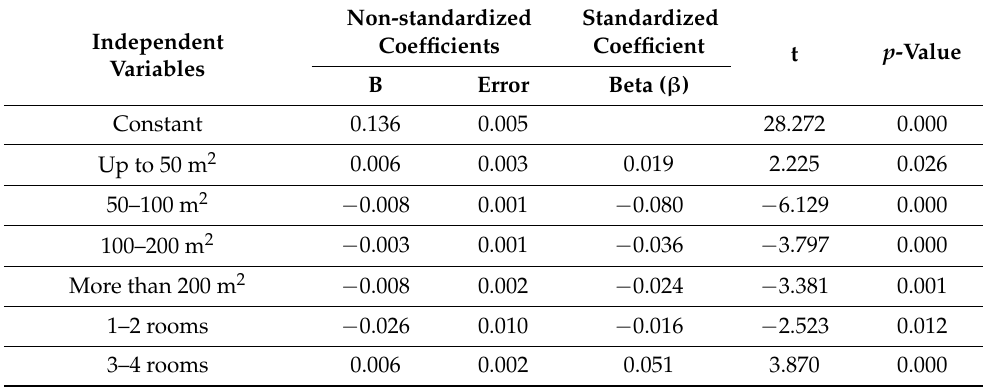
Table 4. Summary of the significance of building area explanatory variables in the multiple